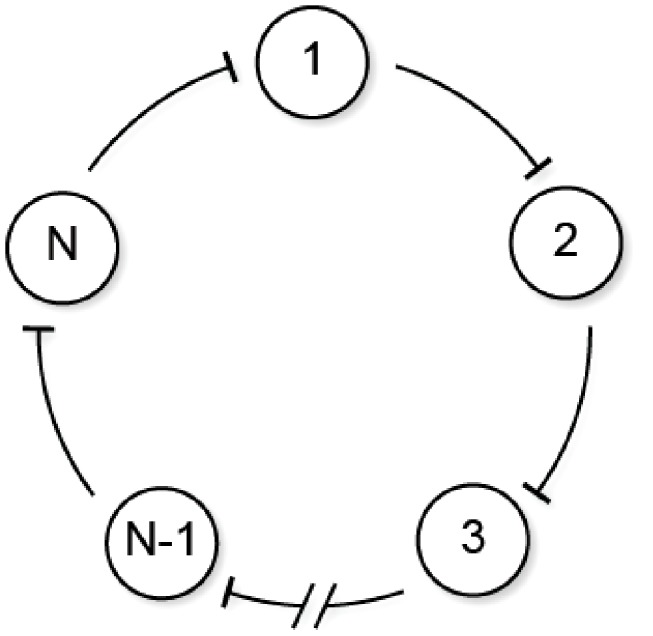

-gene repressilator.